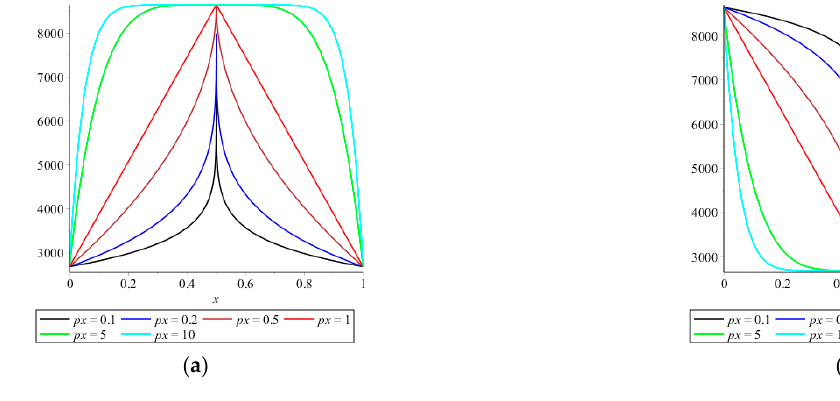
Figure A4. Density evolution [kg.m − 3 ] of ( a ) FGM1-X; ( b ) FGM2-X.